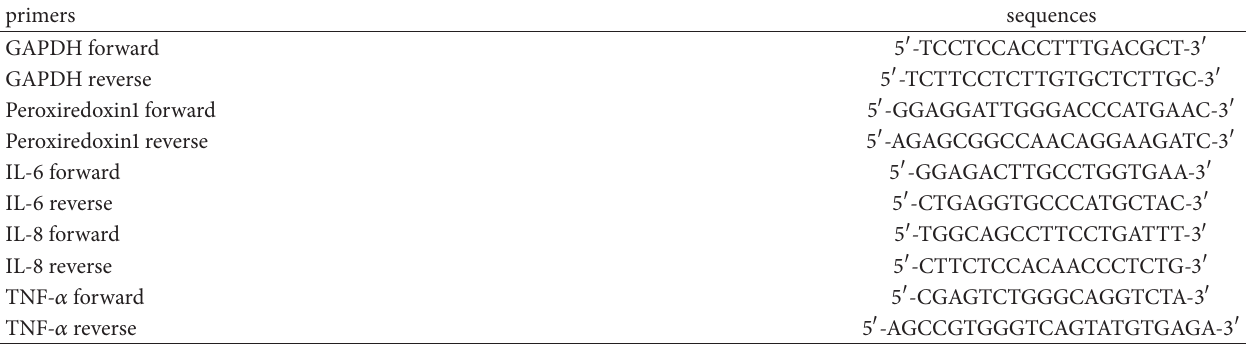
Table 1: Primer sequences used reverse